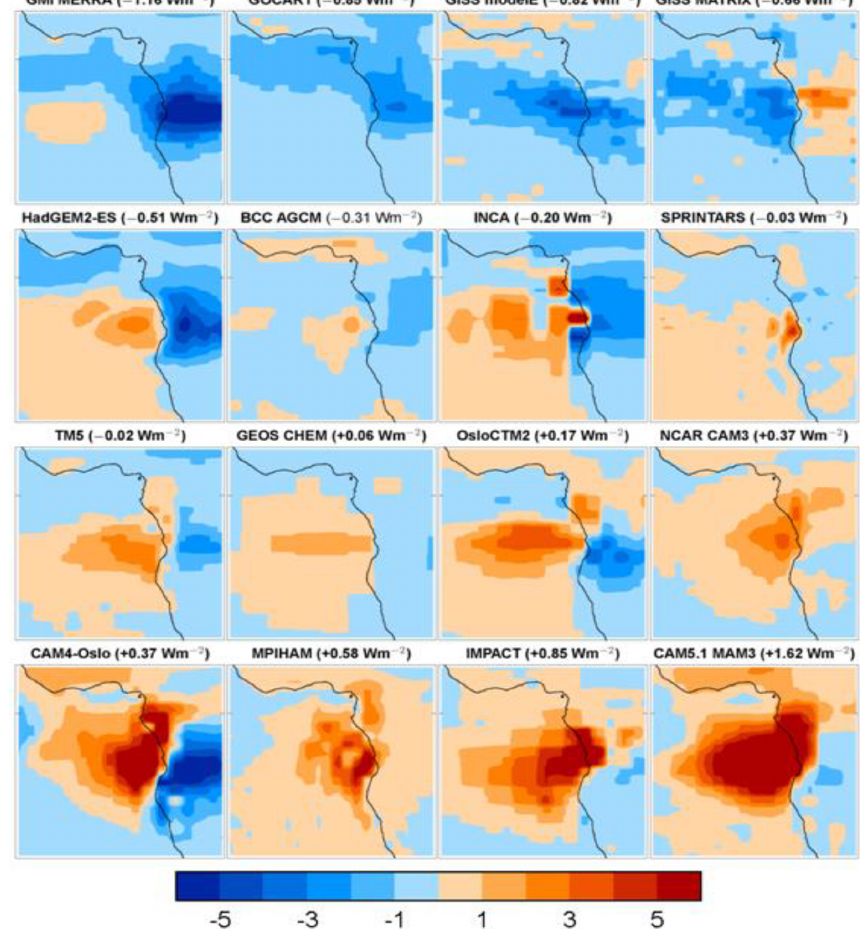
Figure 2. The annual mean direct radiative forcing (aerosol–radiation interaction) of BBA calculated by 16 different AEROCOM models. Units are Wm − 2 . The most negative radiative forcing is in the top left-hand corner, while the most positive radiative forcing is the bottom right-hand corner. Reproduced according to Zuidema et al.